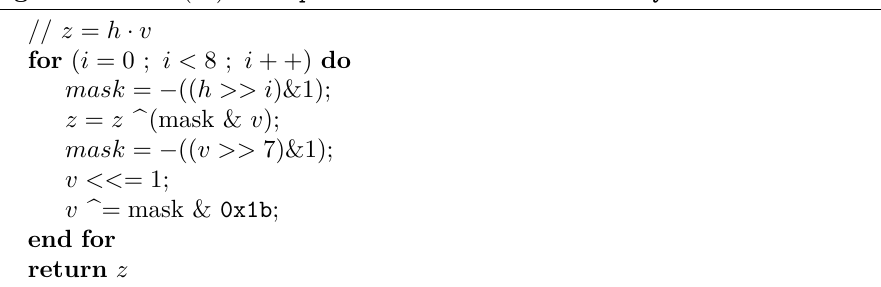
Algorithm 6 GF(2 8 ) Multiplication (instructions only) .